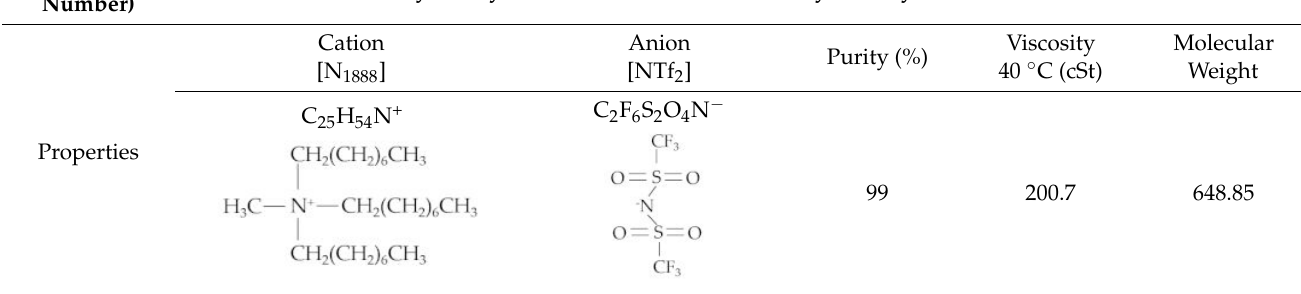
Table 3. Chemical composition and properties of the tested ionic